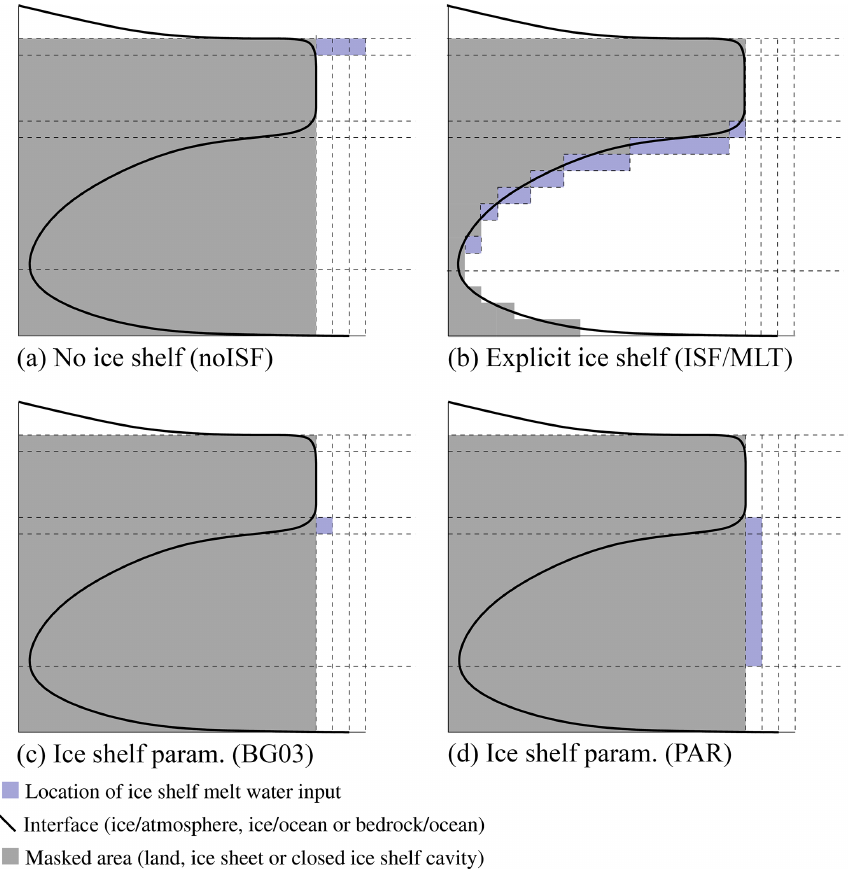
Figure 1. Freshwater and associated latent heat introduced (a) at the surface (R_noISF), (b) beneath the ice shelf (A_ISF, R_ISF and R_MLT), (c) at the ice shelf base level (A_BG03) and (d) over the depth range of the ice shelf base (A_PAR and